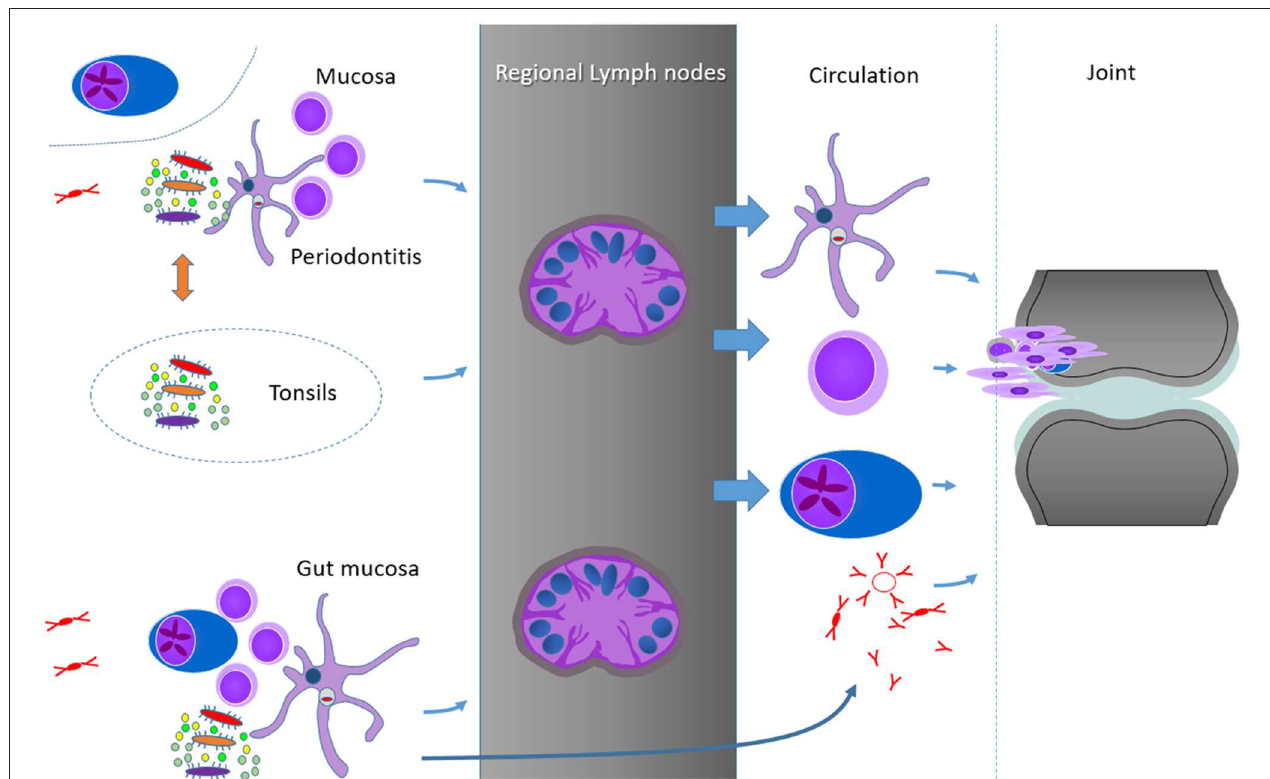
FIGURE 2 | Hypothetical summary schedule of some of the possibilities to connect the mucosal sites and RA joints, from top to bottom: persistent bacterial components in DC and other phagocytosing cells, shaping of the T cell memory at mucosal sites, plasmablasts or plasma cells and soluble factors, as exemplified by antibodies (IgG monomers, IgM pentamers, and IgA dimers). Important for the control of the mucosal responses are probably the clearing regional and secondary lymph nodes. As we identified no reports on germinal center responses in the periodontal tissues, but some similarities between the subgingival periodontal and the palatinal microbiome, we include the tonsils as another possibility of mucosal activation of immune processes in